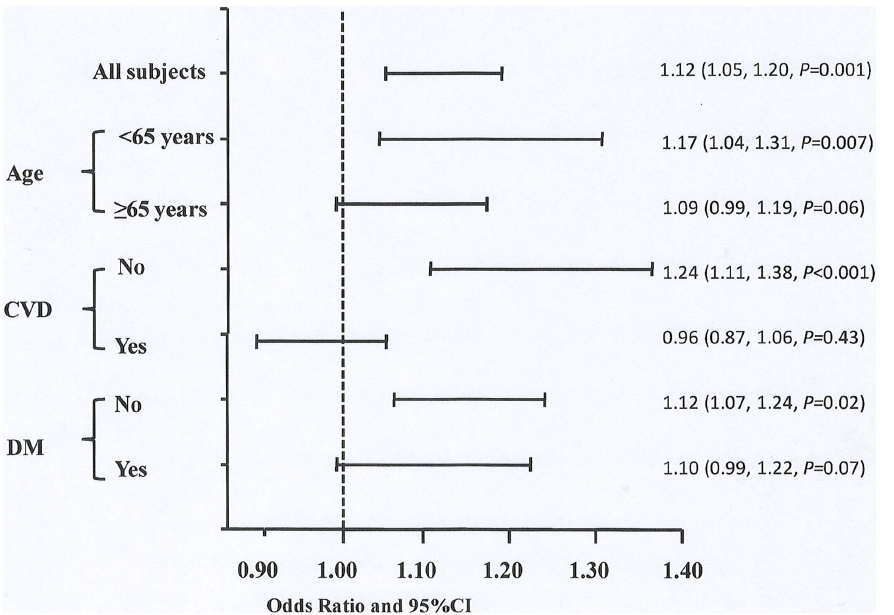
Figure 2. Risk of CVD mortality in all subjects and subgroups. Subgroups were divided by age $ 65 years or , 65 years, with or without CVD or DM at baseline. All models are adjusted for age, gender and center size. Abbreviations: UA, uric acid; CDV, cardiovascular disease; DM, diabetes.